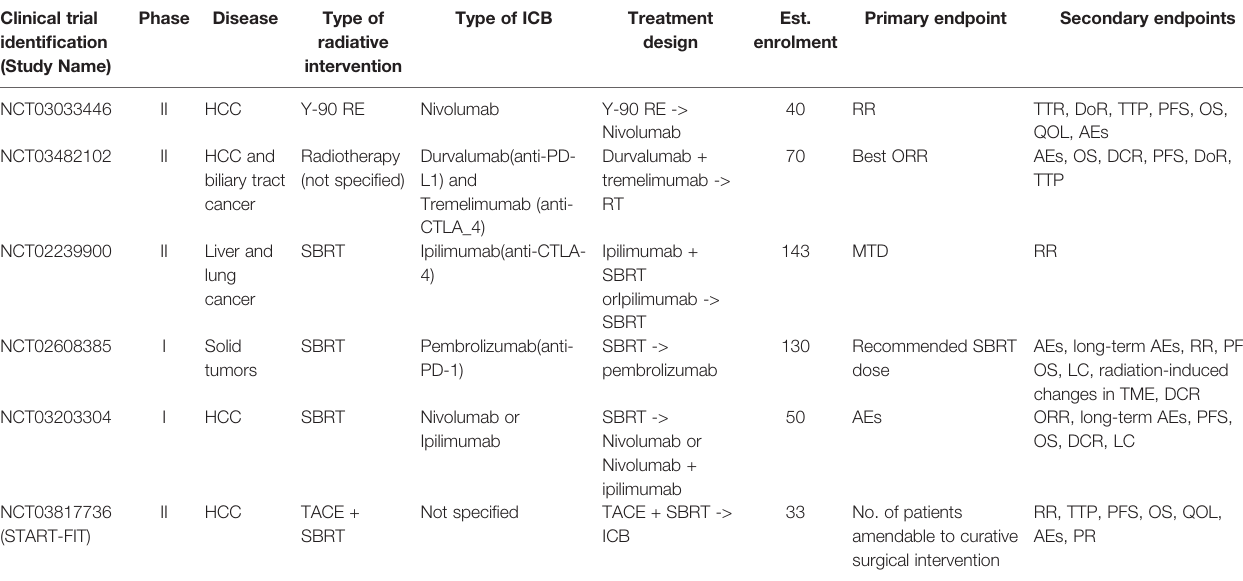
TABLE 2 | Ongoing clinical trials investigating combined use of RT and ICB in HCC/liver cancer. Clinical trial identi fi